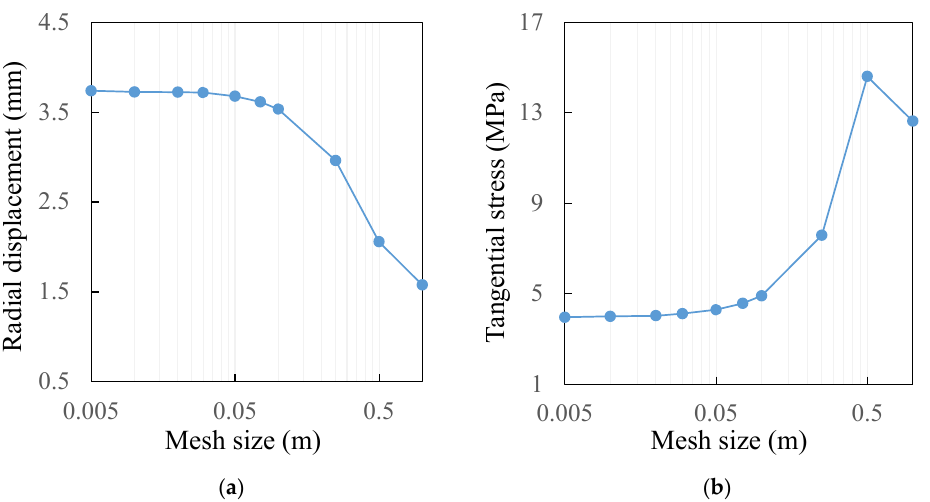
Figure A9. Variations of ( a ) radial displacement and ( b ) tangential stress at point M as functions of mesh size.